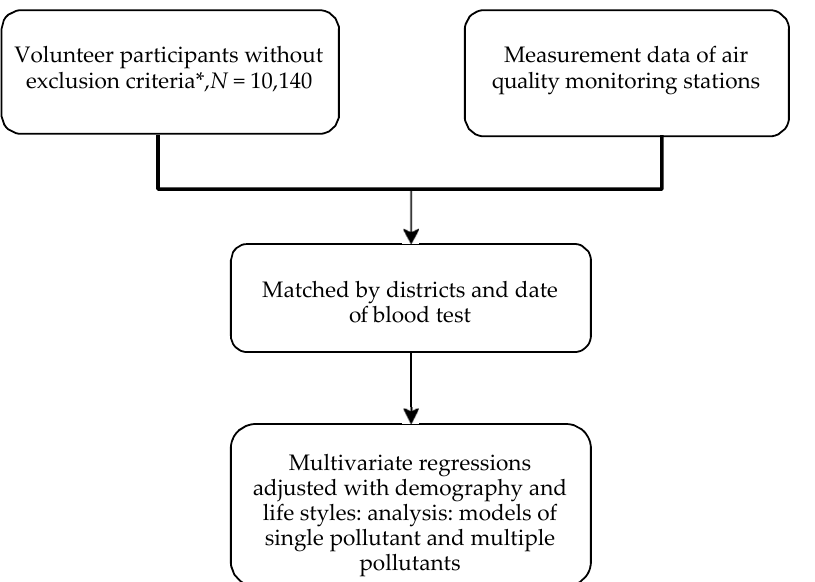
Figure 1. Brief of method steps. *, exclusion criteria: pregnancy, current malignancy diseases, history of auto-immune diseases, possible infectious conditions (such as common cold) or fever, and age < 30 years-old.